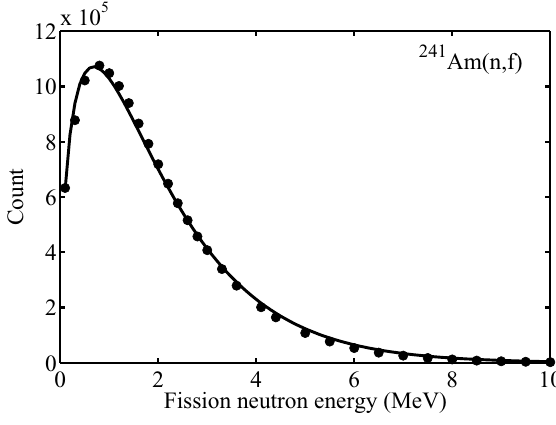
Figure 4. The fission neutrons spectrum of 241 Am(n,f) reaction.